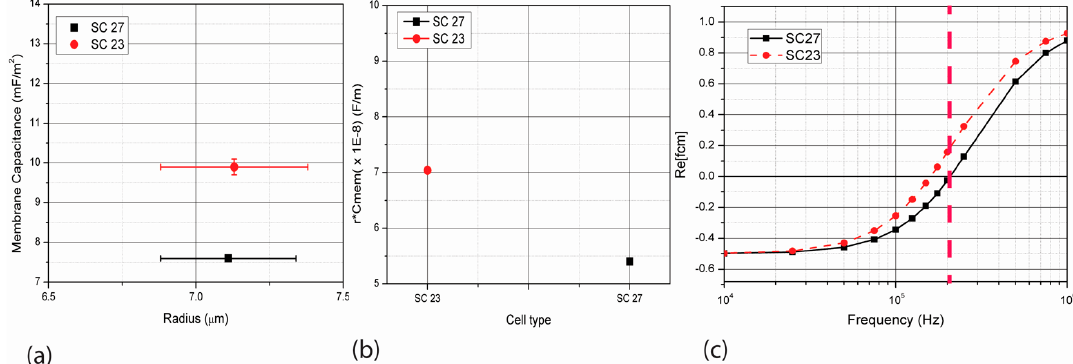
Figure 2. ( a ) The radius and membrane capacitance of different cells considered in this work as obtained experimentally by Labeed et al. [11]. The membrane capacitance of SC23 cells is 9.9 ± 0.2 mF/m 2 while that of SC27 is 7.6 ± 0.3 mF/m 2 . The cell radius lies between 6.57 and 7.75 µm; ( b ) The product of radius and membrane capacitance for SC23 and SC27 is different and can be used to further distinguish the two types of cells. The values of rC mem for SC27 and SC23 used here are (5.40 ± 0.06) × 10 − 8 F/m and (7.50 ± 0.05) × 10 − 8 F/m respectively. Note the small deviation on the average values ( c ). The values of the real part of the Clausius Mossotti factor Re [ f CM ] for SC23 and SC27 as frequency changes are obtained using Equation (2) using the r and C mem values shown in Figure 2a. At the frequency of 200 kHz (dashed red line), the cells SC23 and SC27 show the highest difference in their Re [ f CM ] values, whereas SC23s show a positive value of 0.15, and SC27s show a slight negative − 0.02.